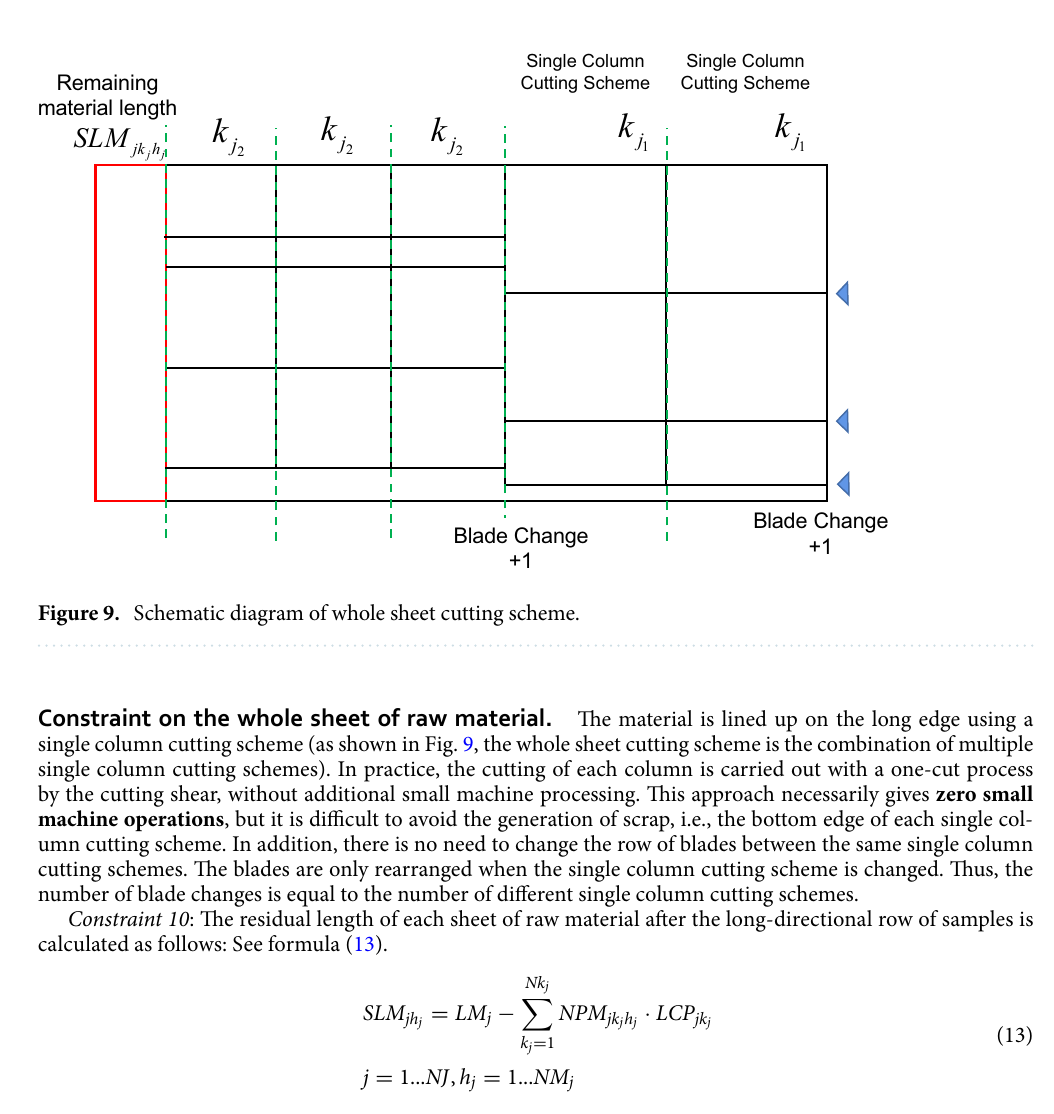
Figure 8. Diagram of maximum one-dimensional column packing.